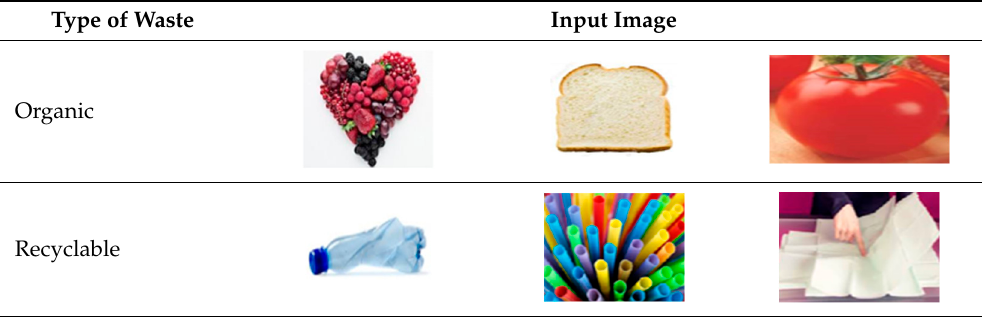
Figure 4. Waste image distribution in the dataset. Table 3. Waste image type in the dataset.